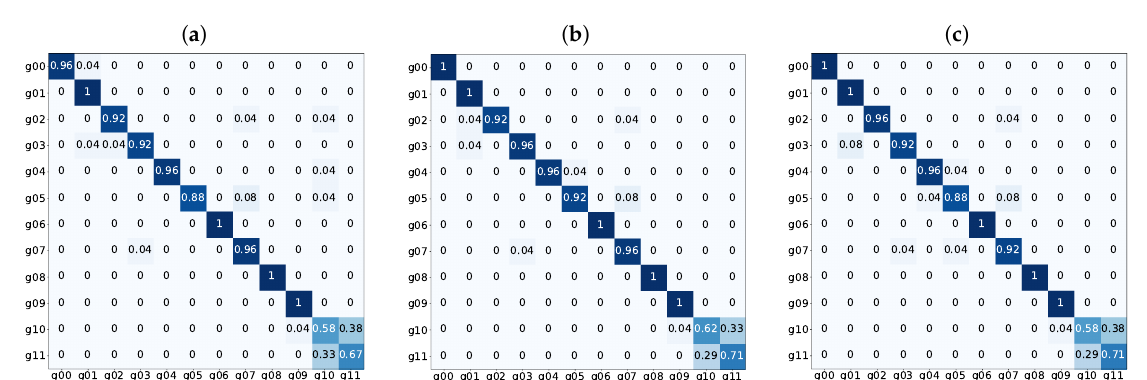
Figure 4. Confusion matrices of the proposed method. From the left, we report the performance of the systems using respectively depth; depth and infrared; depth, infrared and RGB data as input. ( a ) Depth; ( b ) Depth + Infrared; ( c ) Depth + Infrared + RGB.